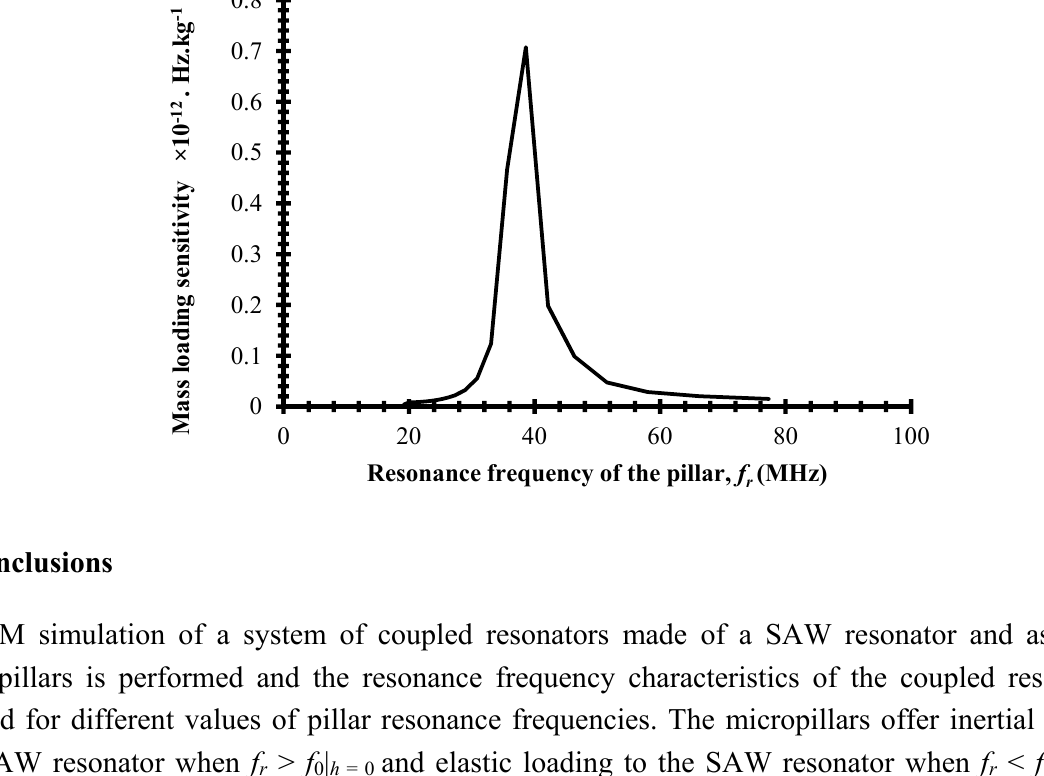
Figure 5. Plot of mass loading sensitivity versus resonance frequency of the pillar.